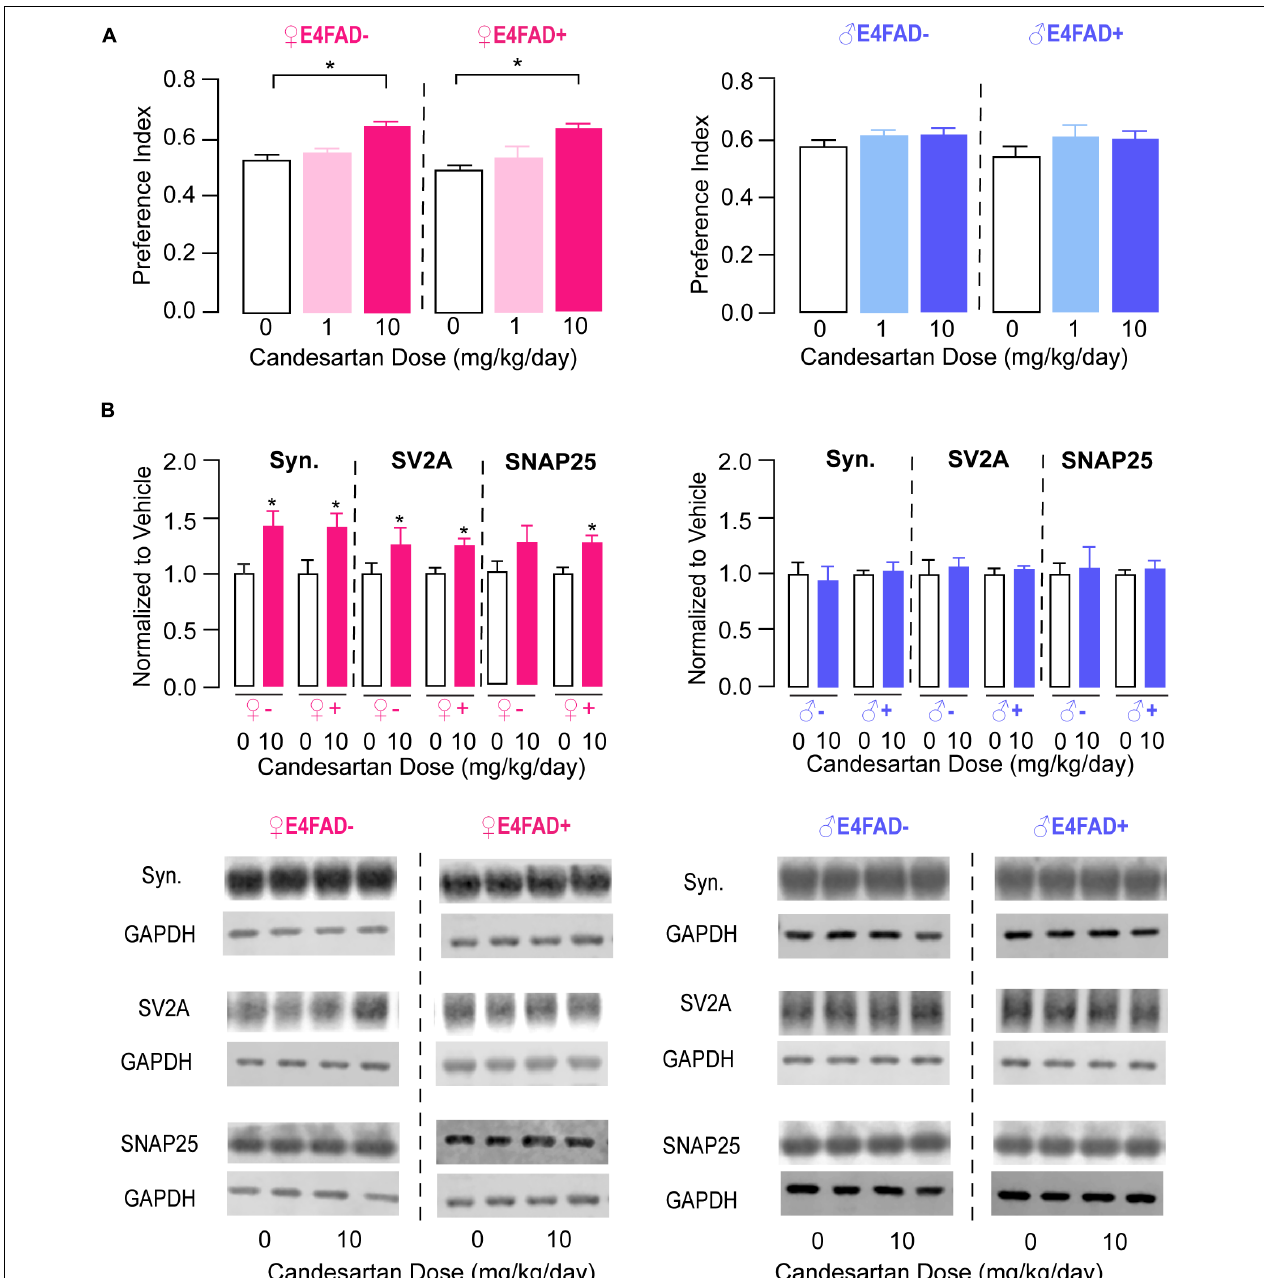
FIGURE 2 | High-dose candesartan treatment resulted in improved memory-relevant behavior and higher hippocampal presynaptic protein levels in female, but not male, E4FAD − and E4FAD + mice. (A) In female E4FAD − and E4FAD + mice treated with 10 mg/kg/day (high dose) candesartan, performance was greater in the novel object recognition test compared to vehicle (0 mg/kg/day) at treatment endpoint [Female E4FAD − : F (2, 25) = 15.29, p < 0.0001. Female E4FAD + : F (2, 42) = 14.64, p < 0.0001]. This effect was not seen in male E4FAD − and E4FAD + mice treated with 10 mg/kg/day candesartan [Male E4FAD − : F (2, 23) = 1.51, p = 0.24. Male E4FAD + : F (2, 26) = 1.23, p = 0.31]. (B) Female E4FAD − and E4FAD + mice treated with 10 mg/kg/day candesartan had higher hippocampal levels of synaptophysin [Female E4FAD − : t (17) = 2.65, p = 0.017. Female E4FAD + : t (19) = 2.89, p = 0.0092], SV2A [Female E4FAD − : t (15) = 2.33, p = 0.034. Female E4FAD + : t (17) = 2.83, p = 0.012], and SNAP25 [Female E4FAD − : t (17) = 1.45, p = 0.16. Female E4FAD + : t (20) = 3.03, p = 0.0067] compared to vehicle when assessed by western blot analysis. Male E4FAD − and E4FAD + mice treated with 10 mg/kg/day candesartan did not have altered hippocampal levels of synaptophysin [Male E4FAD − : t (10) = 0.33, p = 0.75. Male E4FAD + : t (9) = 0.34, p = 0.74], SV2A [Male E4FAD − : t (10) = 0.43, p = 0.67. Male E4FAD + : t (9) = 0.66, p = 0.53], or SNAP25 [Male E4FAD − : t (10) = 0.25, p = 0.81. Male E4FAD + : t (9) = 0.56, p = 0.59] compared to vehicle. Quantification of each protein was normalized to GAPDH as a loading control and all data are expressed as a ratio to vehicle-treated mice. All data expressed as mean + / − SEM. * p < 0.05 by one-way ANOVA and Dunnet’s post-hoc analysis for candesartan dose comparisons to vehicle (A) and by Student’s t -test (B) . See Supplementary Table 2 for details on n sizes and statistical